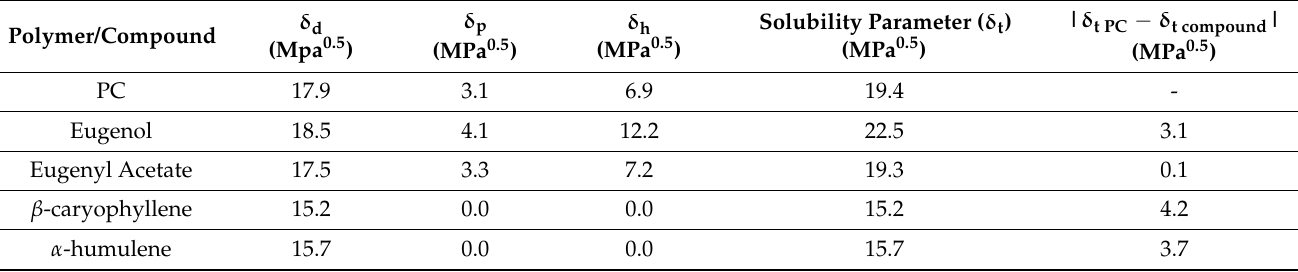
Table 5. Estimation of Hansen-type solubility parameters at 25 ◦ C by the group contribution method, using the Van Krevelen and Hoftyzer method